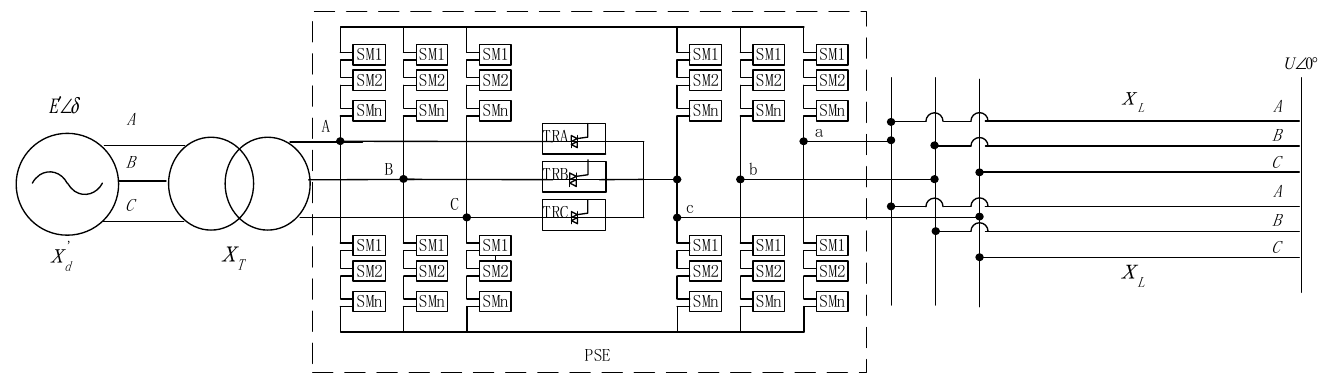
Figure 8. Main circuit of the phase sequence exchanging system.